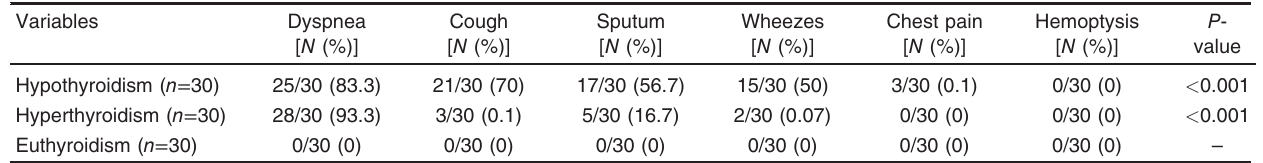
Table 3 Frequency of common respiratory symptoms among the studied groups Variables